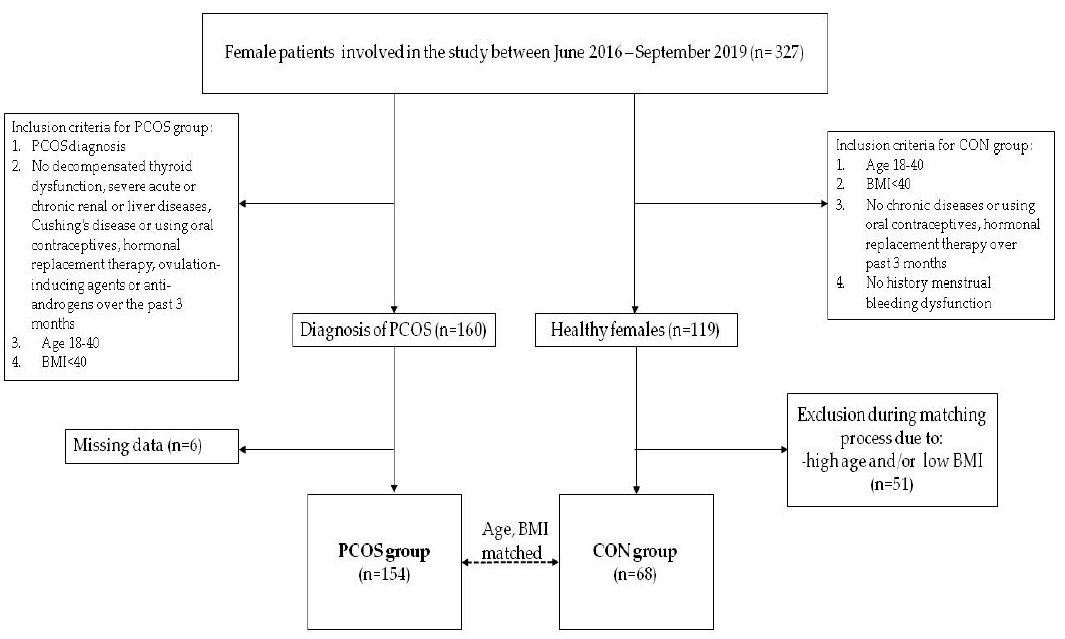
Figure 1. Study participant selection